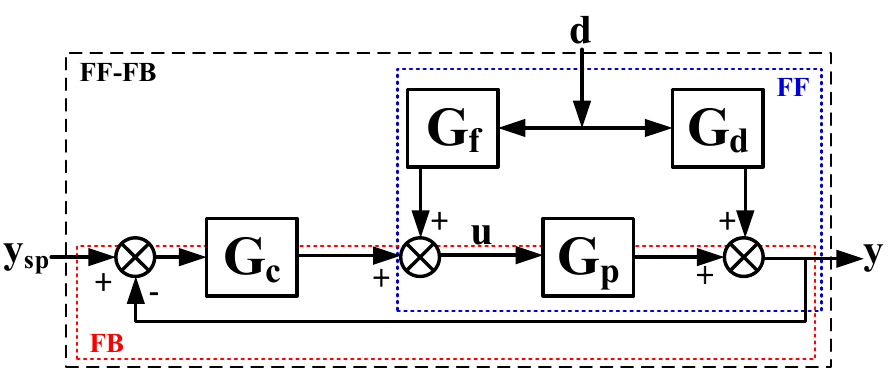
Figure 4. Block diagram for feedforward (FF) control, feedback (FB) control and feedforward-feed- back (FF-FB) control. (d: disturbance, y sp : set point of controlled variable, y: controlled variable, u: manipulated variable, G p : process transfer function, G c : feedback controller transfer function, G d : disturbance transfer function, G f : feedforward controller transfer function).